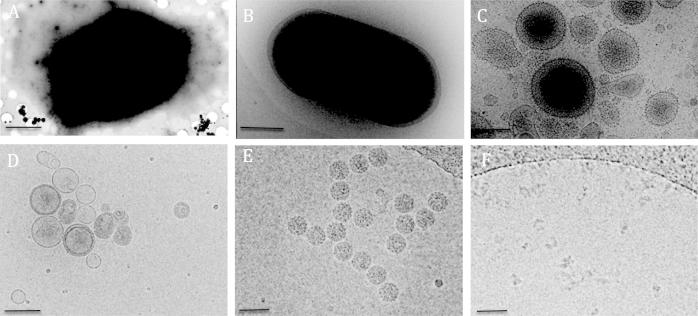
Multi-scale imaging by cryo-EM. A) Eukaryotic cells (scale bar 6 μm). B) Prokaryotic cells (scale bar 0.5 μm). C) Isolated organelles, in this case microsomes (scale bar 200 nm). D) Synthetic liposomes (scale bar 100 nm) E) Viruses (scale bar 50 nm). F) Macromolecular complexes (scale bar 25 nm).